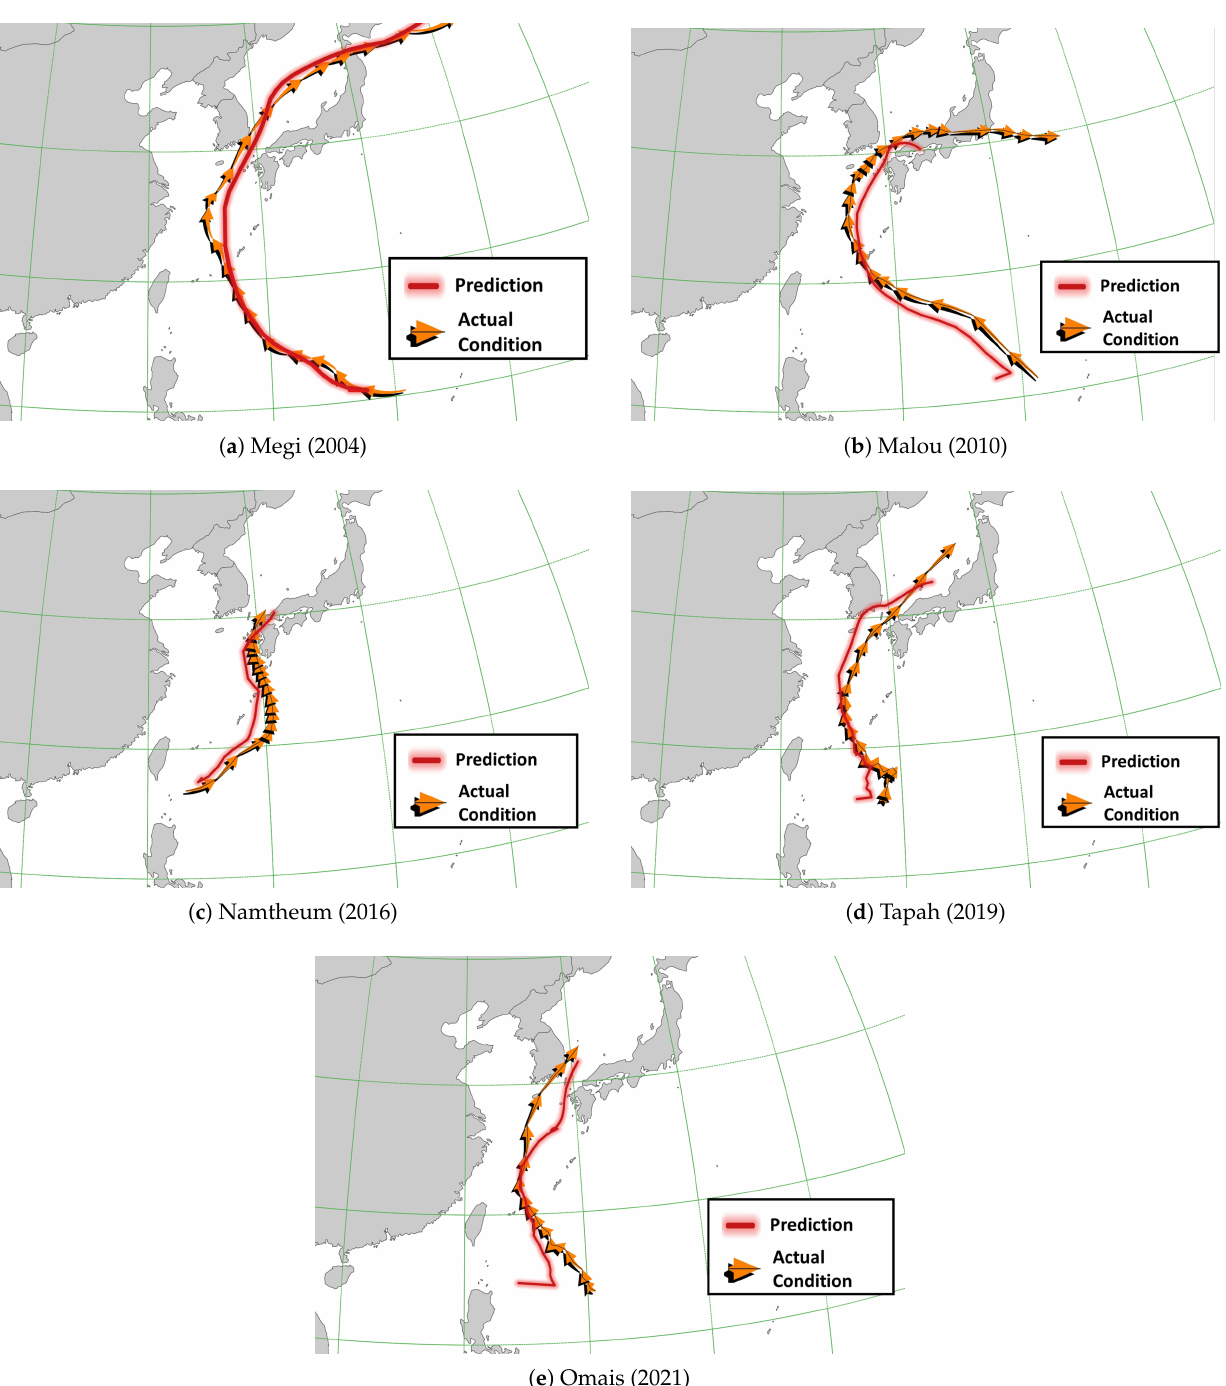
Figure 11. Actual versus predicted typhoon tracks: ( a ) Megi 2004, ( b ) Malou 2010, ( c ) Namtheum 2016, ( d ) Tapah 2019 and ( e ) Omais